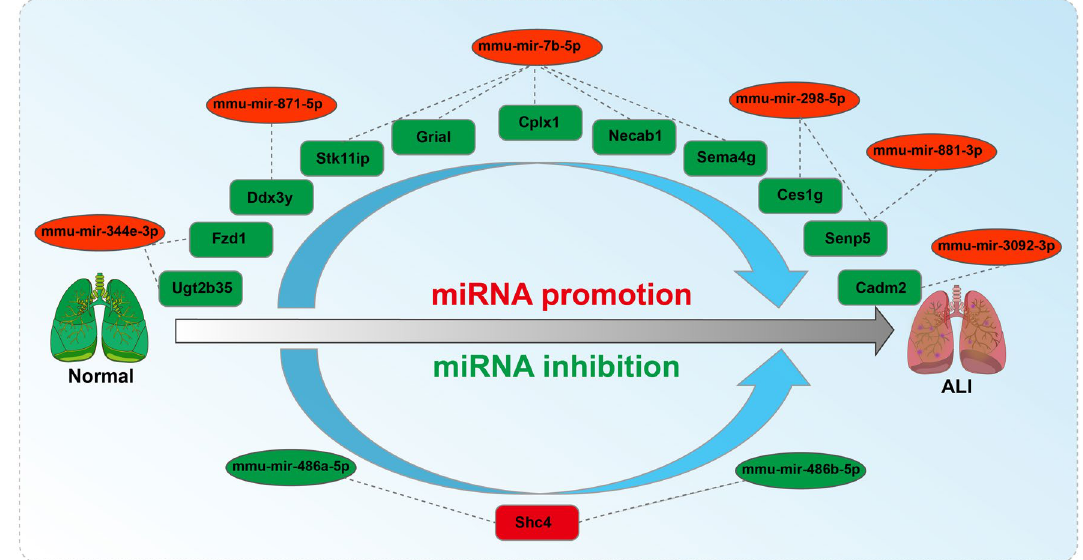
Figure 6. The potential miRNA-mRNA regulatory network of ALI. Upregulated miRNA and downregulated mRNA regulatory network axes included mir-344e-3p-Ugt2b35/Fzd1, mir-7b-5p-Stk11ip/Gria1/Cplx1/Necab1/ Sema4g, mir-298-5p-Ces1g/Senp5, mir-881-3p-Senp5, mir-871-5p-Ddx3y and mir-3092-3p-Cadm2; the downregulated miRNA and upregulated mRNA regulatory network axes included mir-486a-5p-Shc4 and mir-